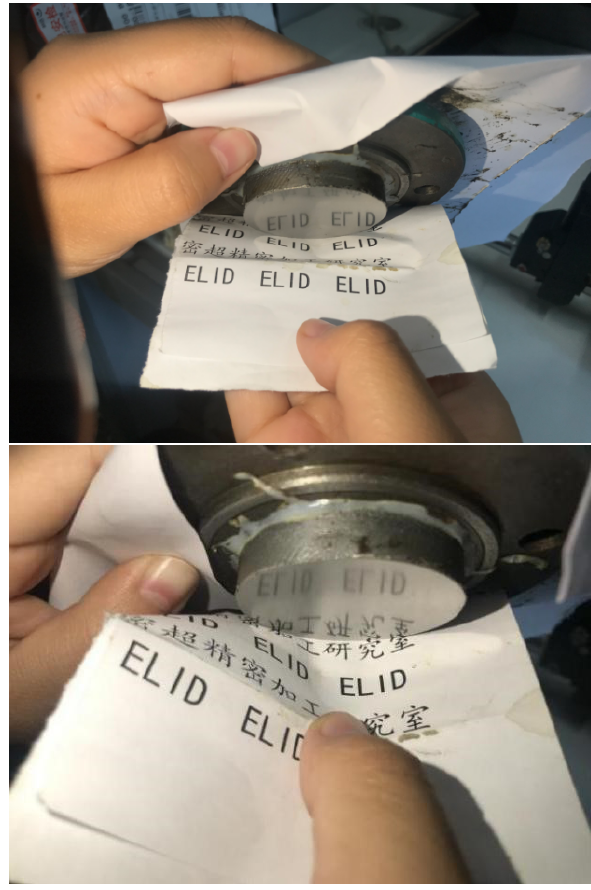
Figure 6: Processed aluminum-based diamond composite